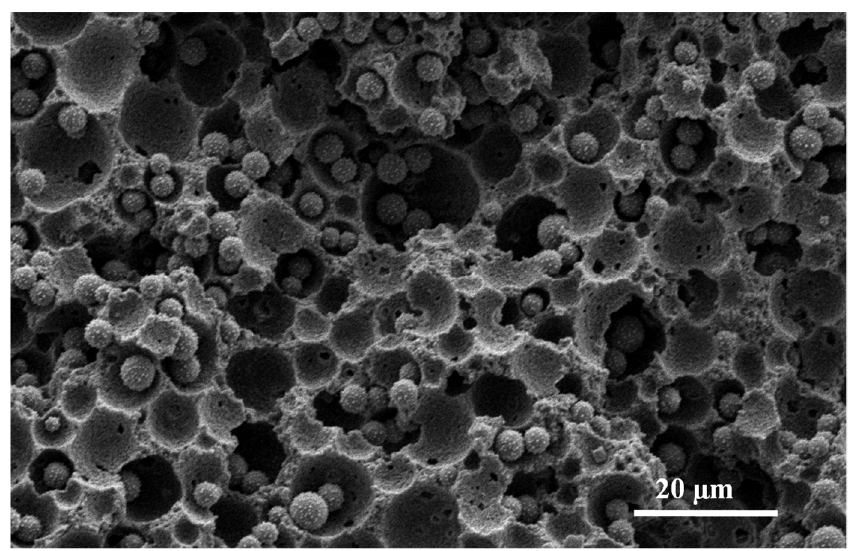
Figure A4. The SEM image of the cross-sectioned surface of the MPTMS silica–PAM monolith unpacked from the column used for the flow adsorption of RhB, as shown in Figure 10B.